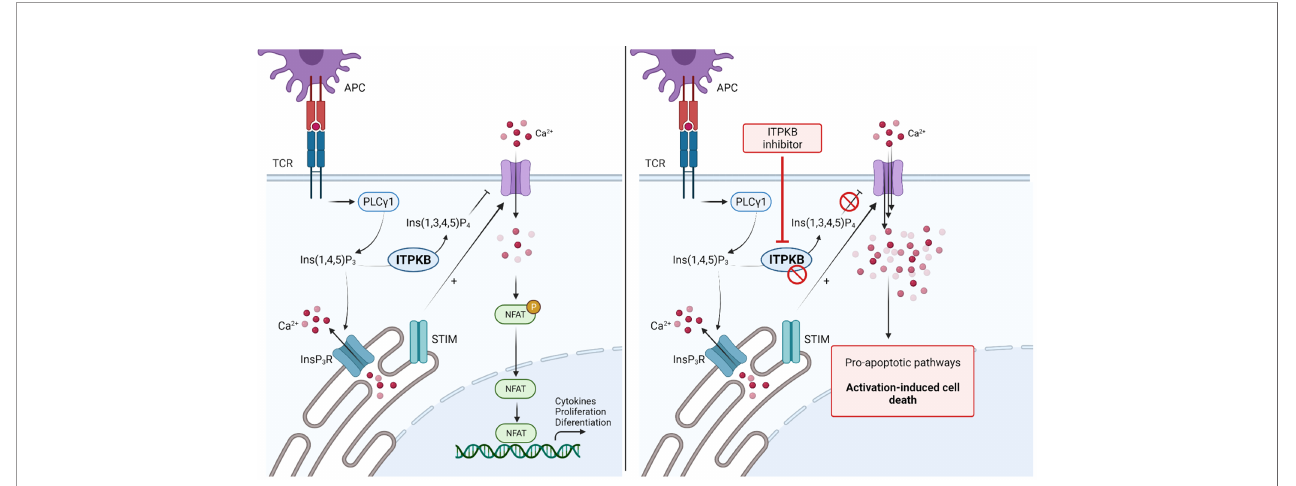
FIGURE 4 | Blockade of Inositol 1,4,5-triphosphate 3-kinase B (ITPKB) as a novel treatment for Graft- versus -Host Disease. TCR stimulation activates downstream PLC g , thereby increasing intracellular IP 3 levels. Binding of IP 3 to IP 3 R activates the release of Ca 2+ from intracellular storage compartments. Furthermore, STIM stimulate the in fl ux of extracellular Ca 2+ to activate NFAT signaling and gene transcription. ITPKB is a rate-limiting step as it catalyzes the formation of IP 4 from IP 3 . IP 4 acts as a control mechanism for calcium signaling by blocking the respective channels in the extracellular membrane. Genetic deletion or inhibition of ITPKB disturbs this control mechanism and leads to increased calcium in fl ux, which stimulates pro-apoptotic signaling pathways, leading to activation-induced cell death. Since ITPKB is predominantly found in hematopoietic cells, this kinase is thought to be a novel target molecule for the treatment of GvHD. Adapted from “ NFAT Signaling Pathway ” , by Biorender.com (2021). Retrieved from